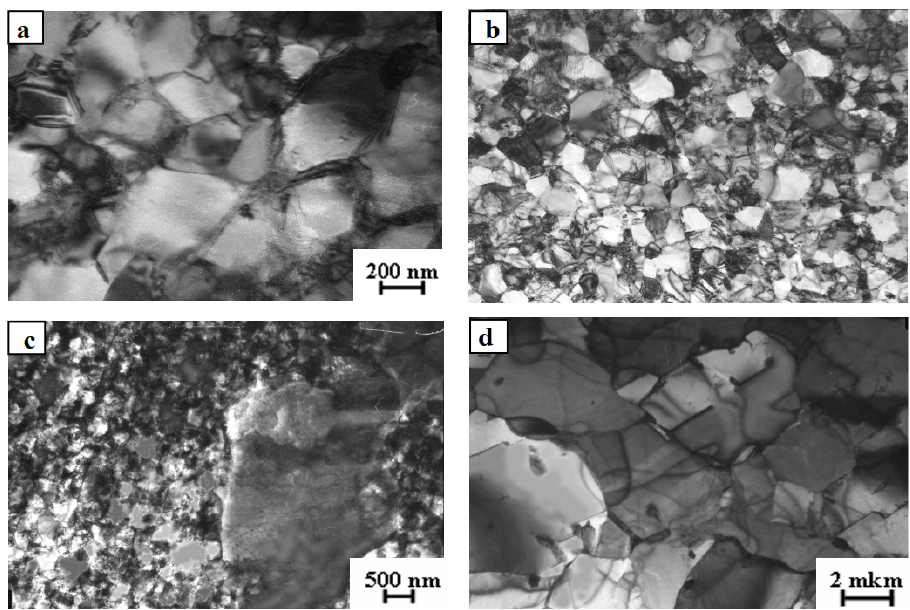
Figure 12. Microstructure of NC nickel after ultrasonic treatment ( a ) and subsequent annealing at the temperatures of 150 ( b ), 250 ( c ) and 300 °C ( d ) [86].